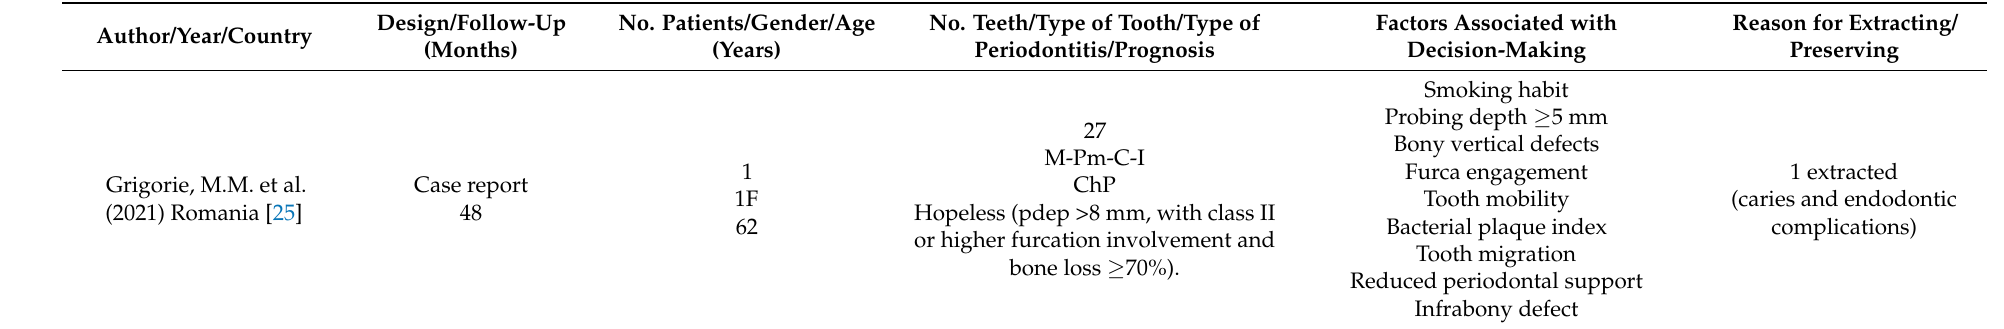
Table 2. Summary of clinical case reports